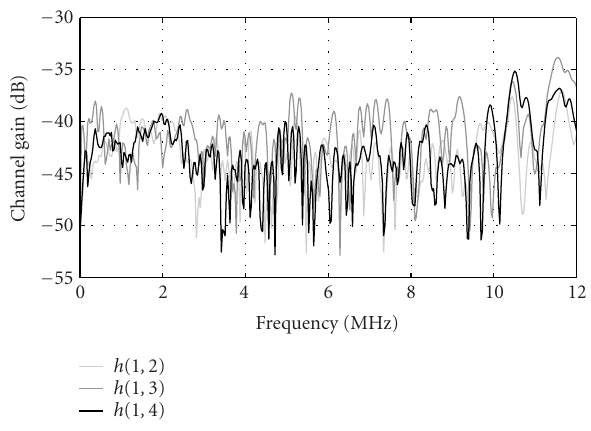
Figure 1: FEXT transfer functions for 0.5 mm British Telecom cable.